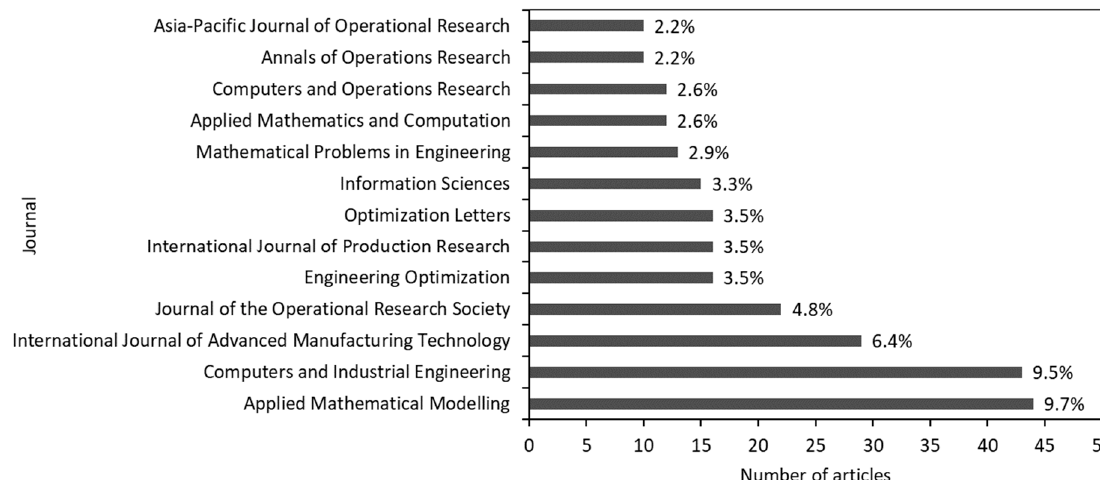
Figure 3. Frequency per journal (journal with ten contributions or more).